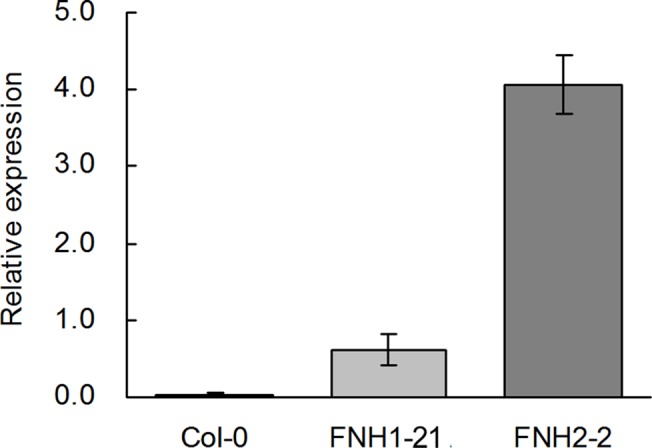

AhLPAT2 Gene Expression in Young Siliques of the Selected Transgenic Lines Overexpressing AhLPAT2.Two transgenic T3 lines, FNH1-21 and FNH2-2, were used. Total RNA was prepared from developing siliques of transgenic lines. Gene expression levels are shown relative to the expression of AtActin7 in each sample. Values are means ± SE (n = 3).